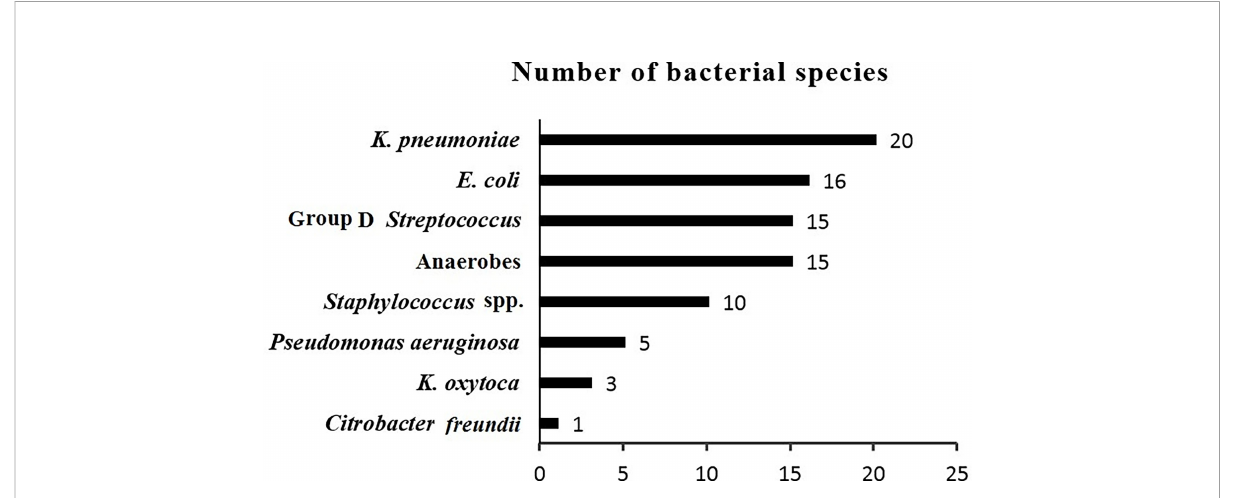
FIGURE 1 Bacterial species from patients with pyogenic liver